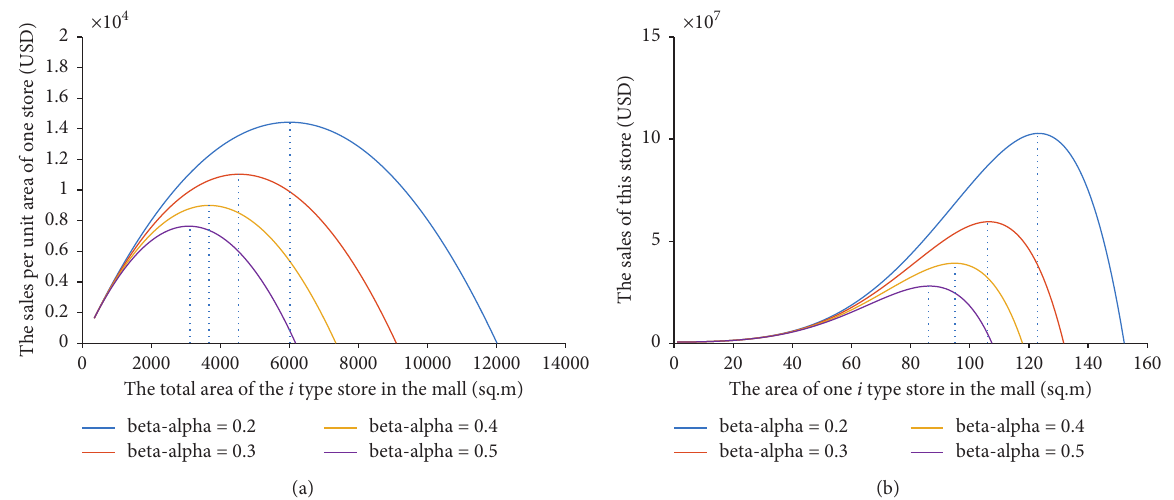
Figure 6: (a) Alternative preference coefficients’ effect on sales of per unit area. (b) Alternative preference coefficients’ effect on one store’s total